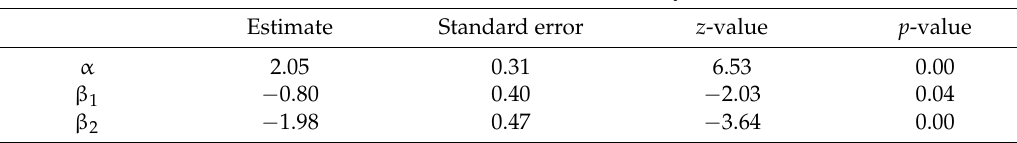
Table 3. Results of generalized linear mixed models concerning the effects of secondary branch position on ( a ) the number of current-year shoots on secondary branches (see Figure 3), ( b ) the mean length of current-year shoots on secondary branches (see Figure 4), and ( c ) the probability of death of a secondary branch. The predictor (position) was a categorical variable having three parts (Distal, Middle, and Proximal), where α corresponds to the estimates of the Distal, α + β 1 to the Middle, and α + β 2 to the Proximal